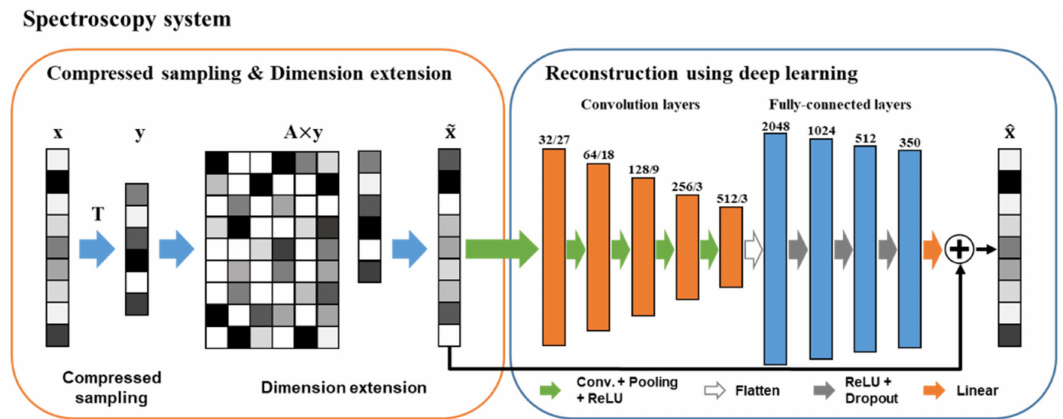
Figure 2. Overview of compressive sensing (CS) spectrosocopy system including the proposed residual convolutional neural network (ResCNN): An input spectrum is compressively sampled by the sensing matrix, and the dimension of measurements is extended by the transform matrix. ResCNN is trained to recover the original spectrum from the extented